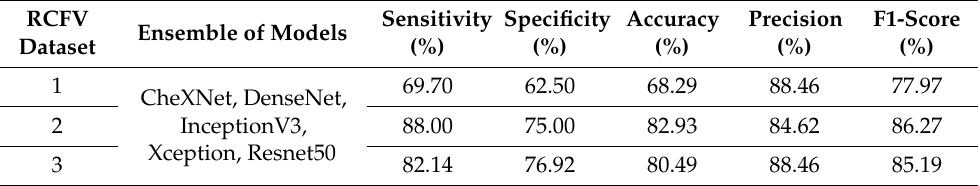
Table 6. An ensemble using the average prediction probabilities of combining five DL models on three RCFV